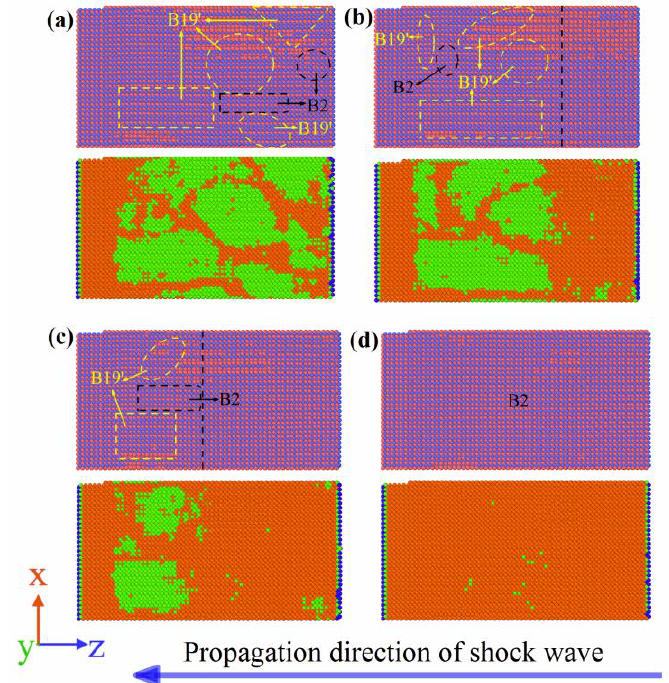
Figure 9. Martensitic transformation at Stage I: ( a ) 0.0 ps; ( b ) 1.0 ps; ( c ) 2.0 ps; ( d ) 3.0 ps. (orange and green represent the B2 phase and B19′ phase, respectively, but blue represents the other phase).